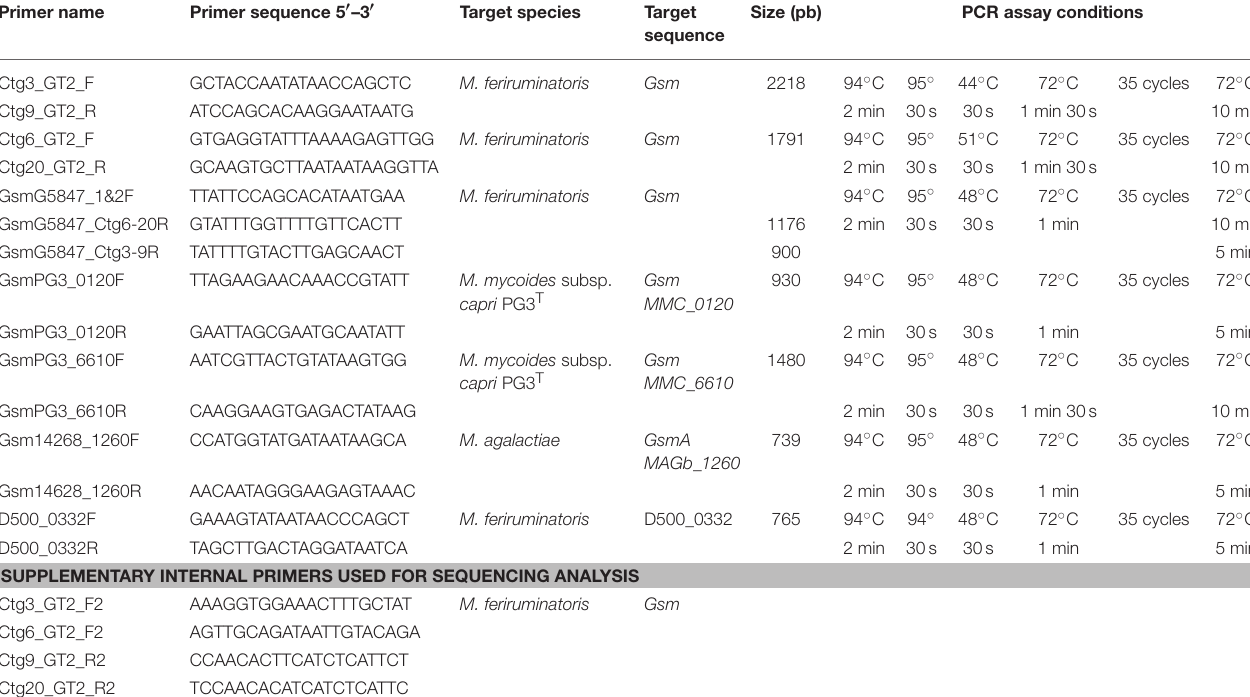
TABLE 2 | Primers used for PCR